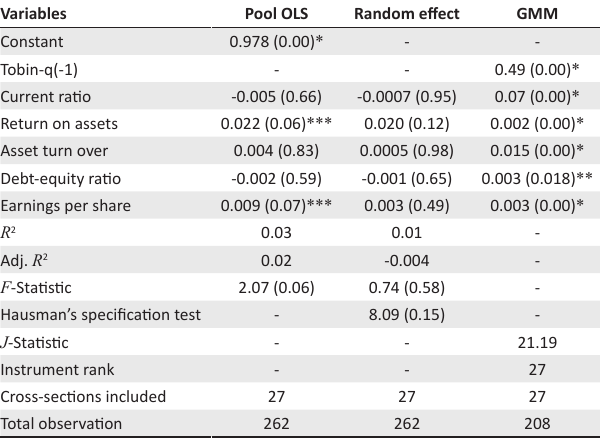
TABLE 5: Dependent variable: Tobin q . Variables Pool OLS Random